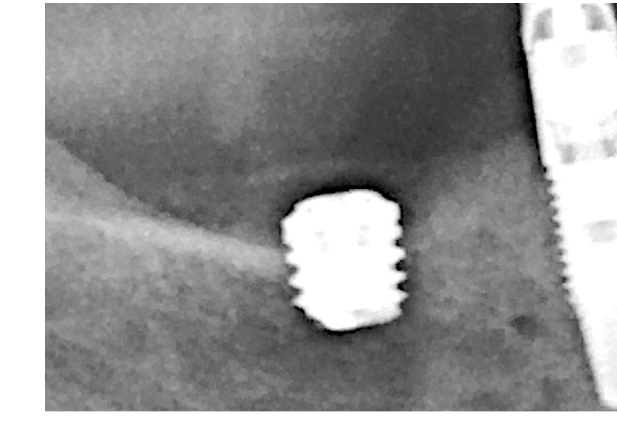
Figure 6. ( a , b ) Scanning Electron Micrographs of the implant surfaces after blood immersion exper- iments. NoCa surfaces ( a ) showed a thick layer mainly composed of red blood cells (red arrows) with scarce fibrillar material (white arrows) while Ca surfaces ( b ) showed a dense fibrin network (white arrows) with embedded platelets (yellow arrows) and some interspersed red blood cells (red arrows). Below each micrograph, a scheme illustrating the phenomena is proposed ( c , d ). The black arrows in ( c ) indicate that most of the fibrin network stays away from NoCa surfaces. Only a thick layer mostly composed of red blood cells stays attached to the NoCa surfaces. On the Ca surfaces ( d ), the clot forms at the surface and contains red blood cells and platelets entrapped within the surface-bound